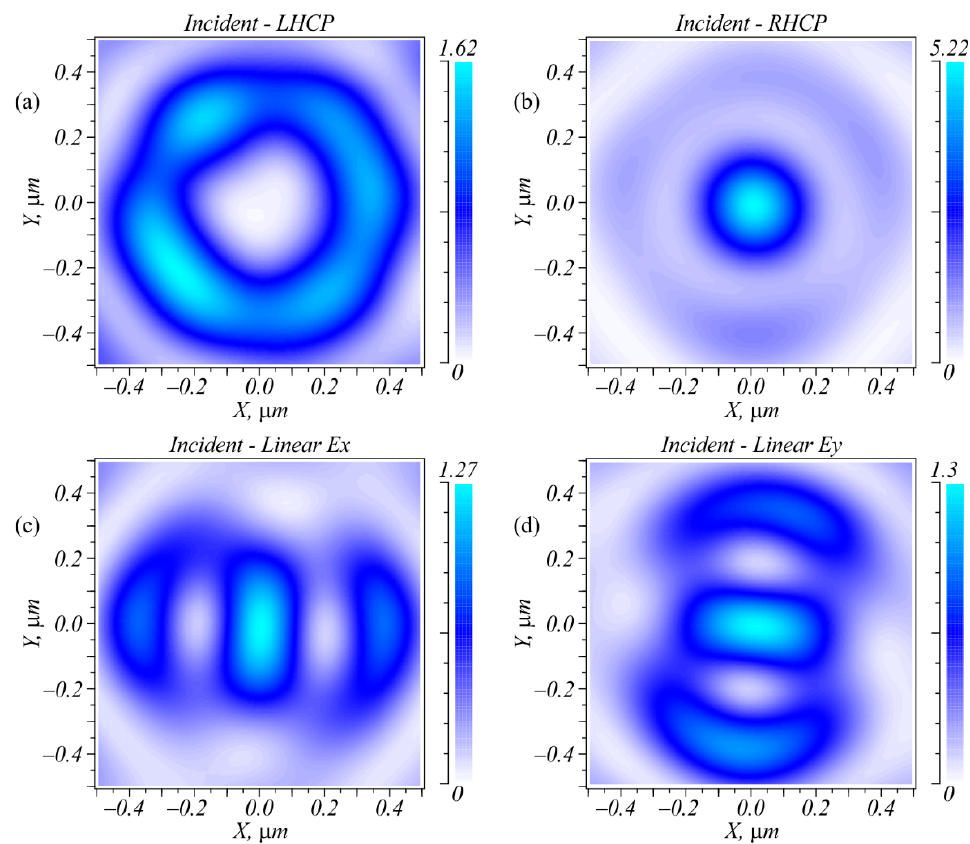
Figure 2. Intensity distributions in the metalens focus (Figure 1) for four different polarizations of the incident field: LHCP ( a ); RHCP ( b ); linear Ex ( c ); linear Ey ( d ).